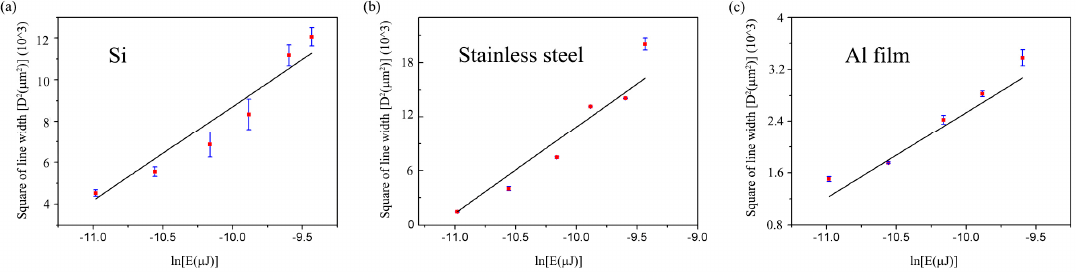
Figure 6. Linear fitting of measured data between the square of line width and logarithm of single pulse energy: ( a ) Si, ( b ) stainless steel, and ( c ) Al film. Table 1. Calculated ω 0 , E th , and I th of Si, stainless steel, and Al film. Specimens